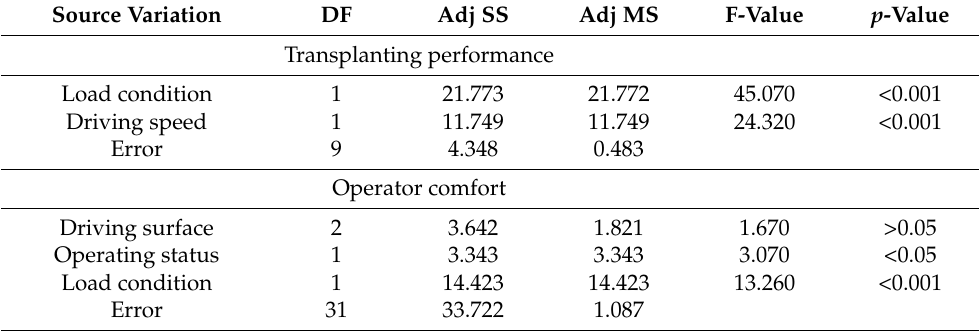
Table 6. Multi-factor ANOVA test showing the individual effects of the considered factors (i.e., driving surface, operational status, and load conditions) on transplanting performance and operator